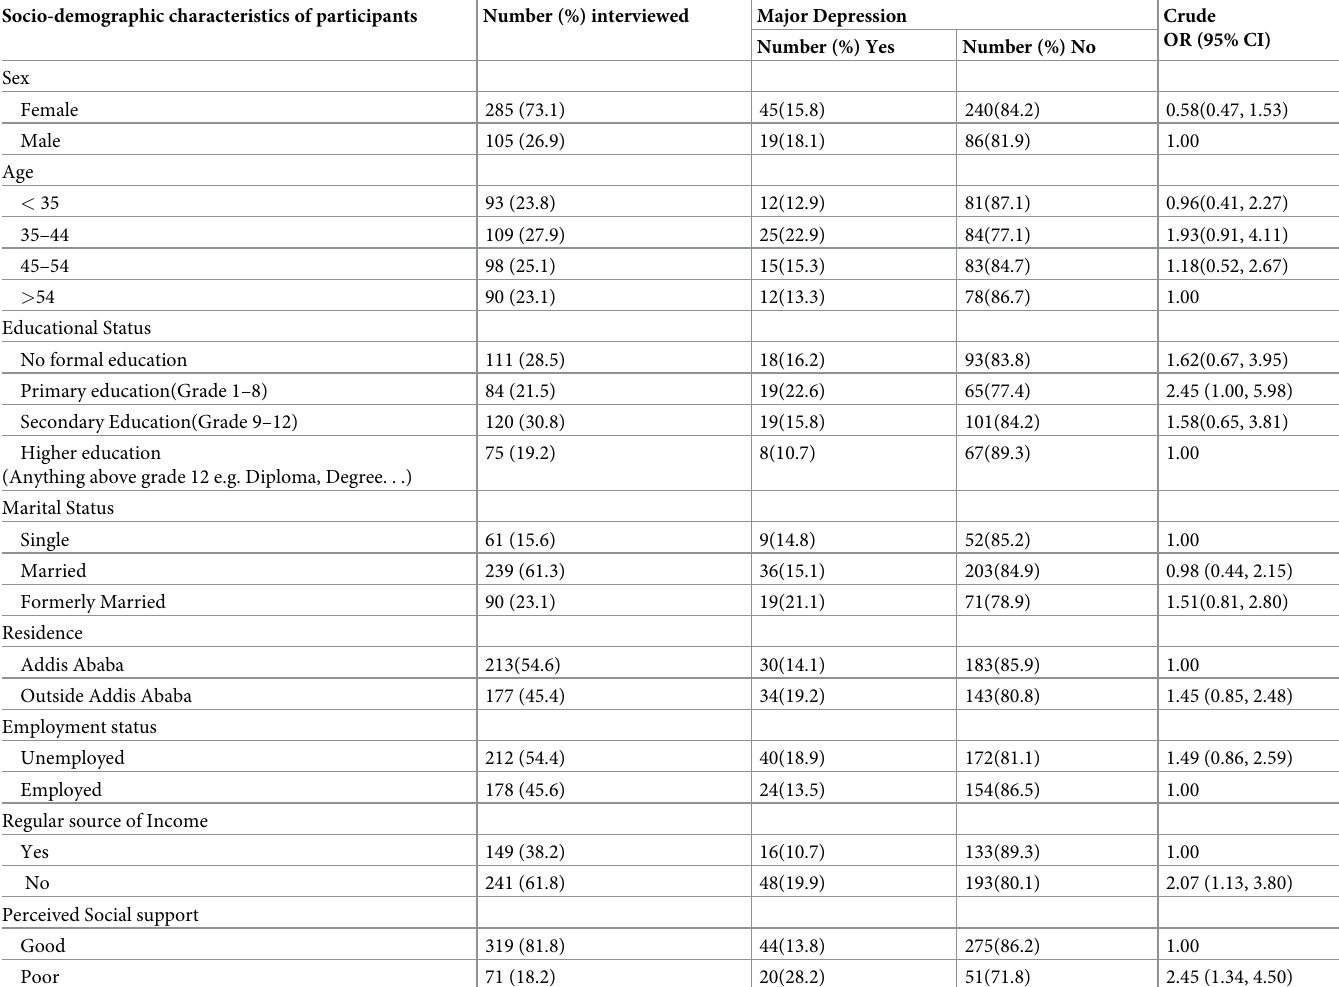
Table 2. Socio-demographic characteristics and correlates of depression among study participants (n =